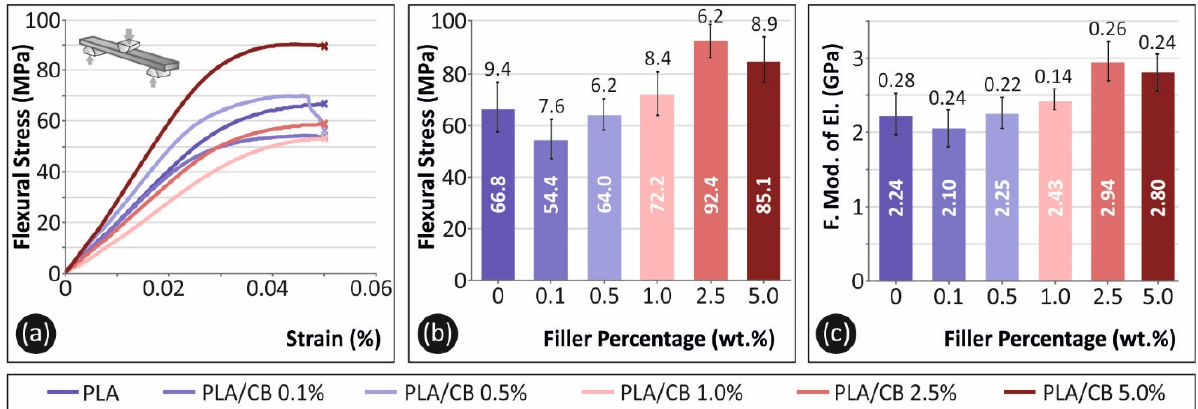
Figure 9. ( a ) flexural stress (MPa) vs. strain (%) representative curves for neat PLA and PLA/CB nanocomposites. ( b ) flexural strength and ( c ) flexural modulus of elasticity average values, along with the calculated standard deviation values, both as a function of the CB different filler loadings (wt.%).